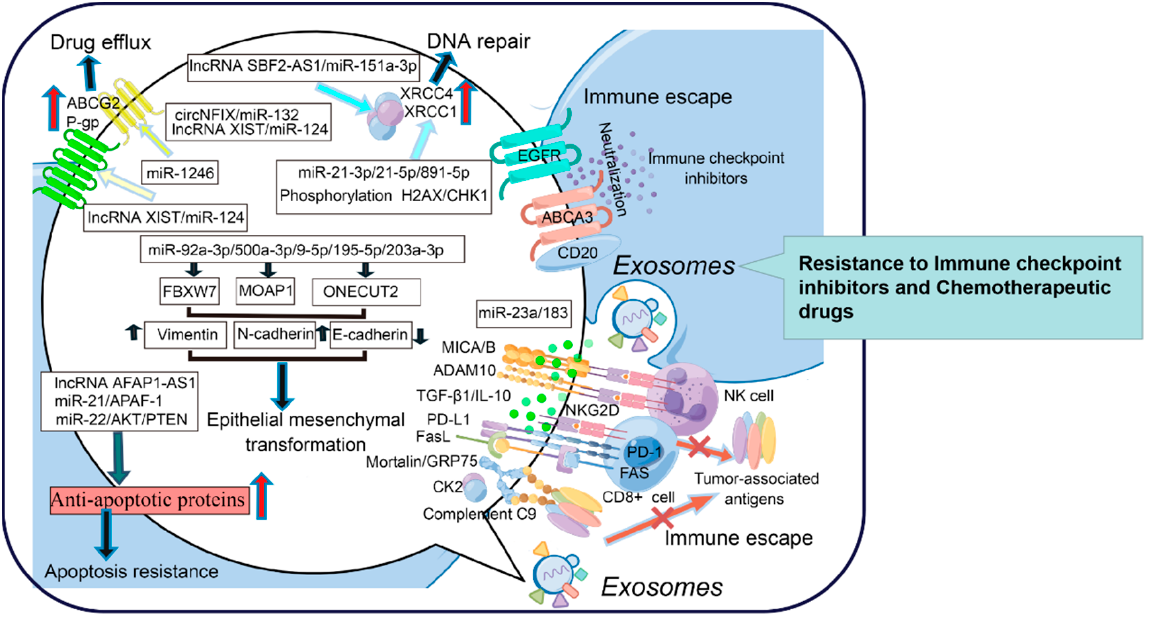
Figure 2. The role of exosomes in promoting drug resistance in tumor cells. ( By